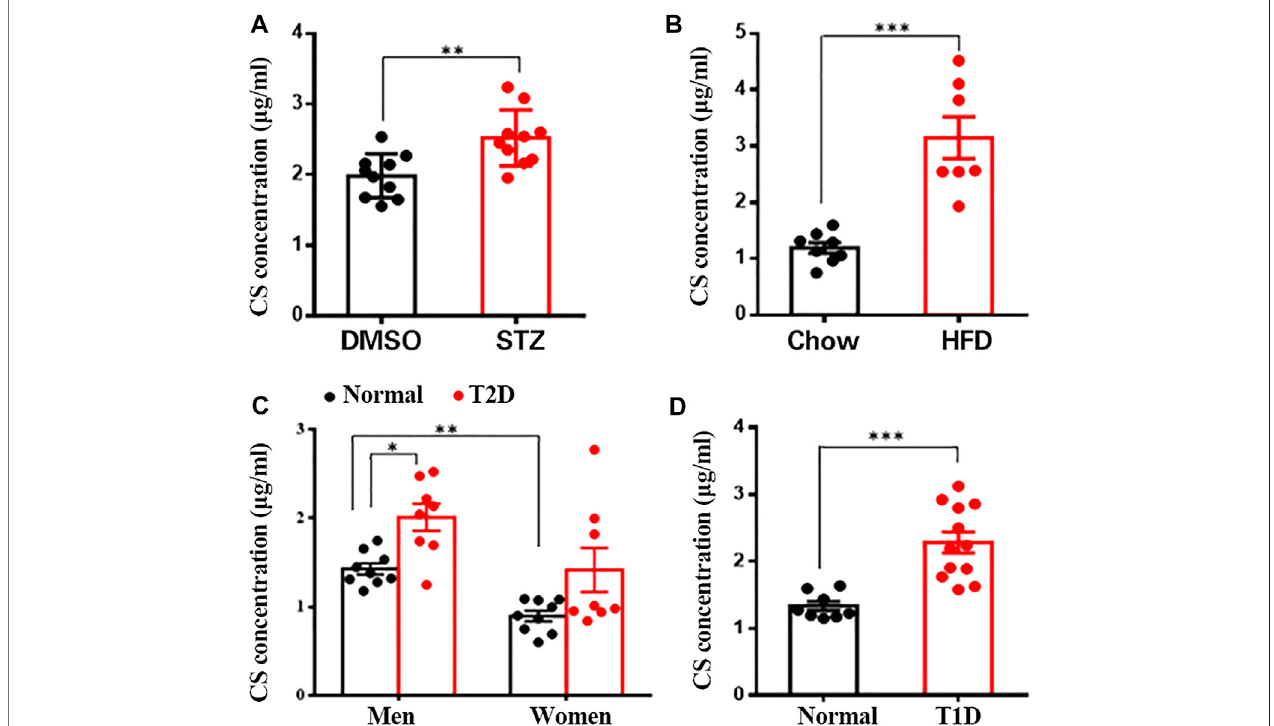
FIGURE 1 | CS levels were increased in blood of diabetic mouse models and patients. Plasma CS levels were determined using a LC-MS/MS. (A) Eight-week-old malemiceweresubcutaneouslyinjectedwithDMSOdailyfor42 days(controlgroup, n =10),micewereinjectedsubcutaneouslySTZ(40 mg/kgofbodyweightdaily)for fourcontinuousdaysfromthe8thdayoftheexperimentaltreatmentperiod(STZgroup, n =8). (B) Eight-week-oldmalemicewerefedwitheitheranormalchowdietora high-fat diet (HFD) for 8 weeks. (C,D) Blood samples from type 2 diabetic (T2D) patients (eight men and eight women) (C) , type 1 diabetic (T1D) patients (12 men) (D) and age-matched healthy volunteers were collected after an overnight fast. * p < 0.05, ** p < 0.01, *** p < 0.001.